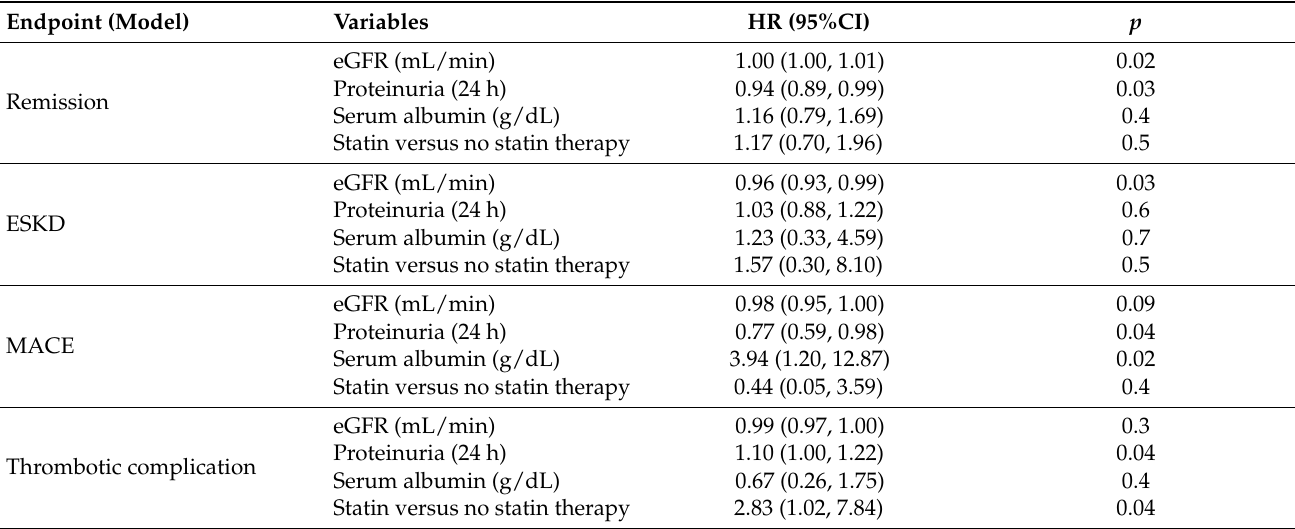
Table 2. Association between statin therapy and remission, ESKD, MACE, and thrombotic complica- tions in four models of Cox regression analysis adjusted for eGFR, proteinuria, and serum albumin at